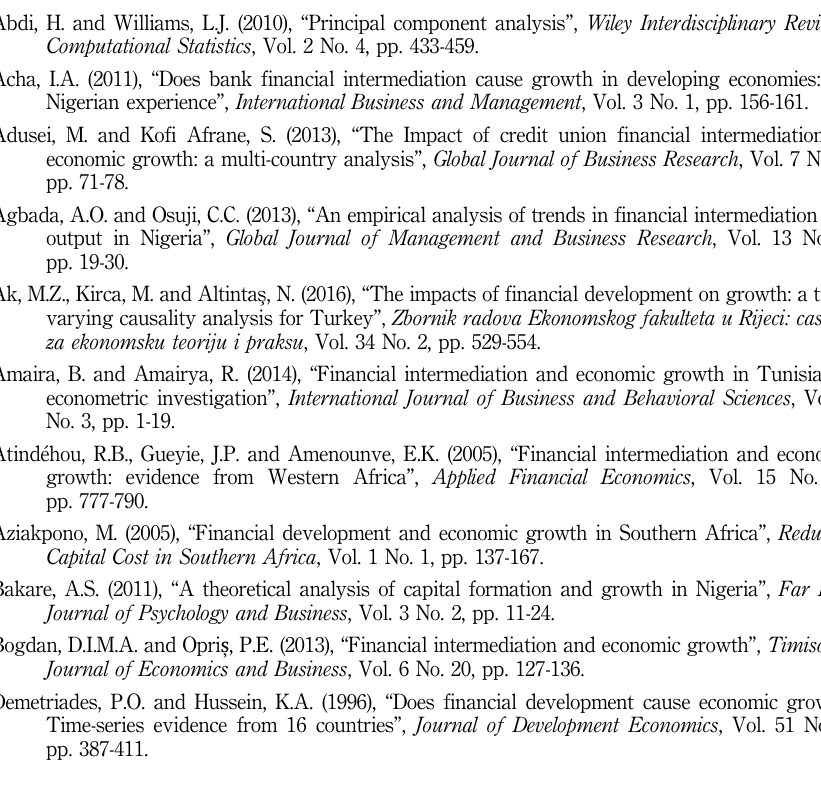
Figure 2. Plots of CUSUM of